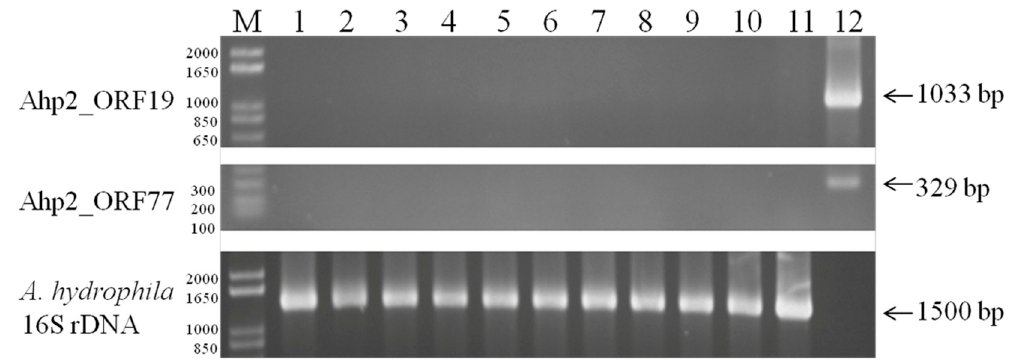
Figure 6. PCR detection of Ahp2 ORF19 and ORF77 in phage-resistant mutants of A. hydrophila